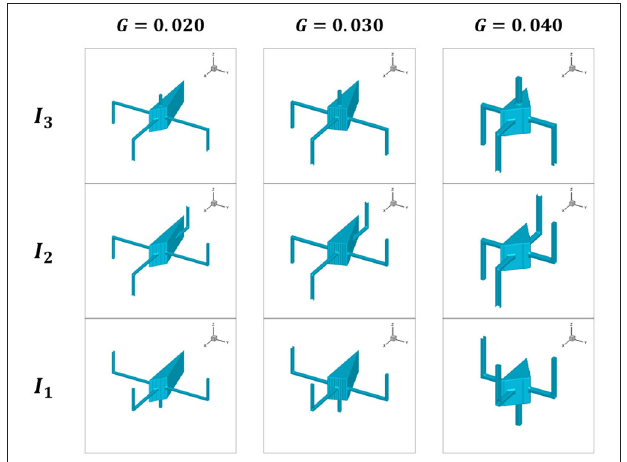
FIGURE 3 | Pore-body filling configurations for the three studied shape factors G = 0.020, G = 0.030, and G = 0.040 during I 1 , I 2 , and I 3